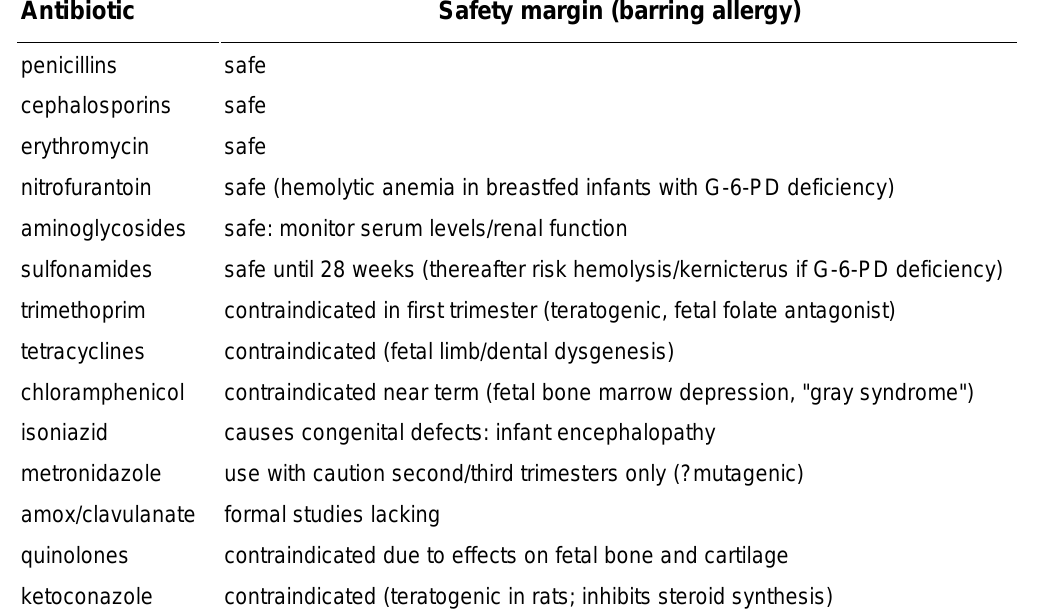
Antibiotic use in